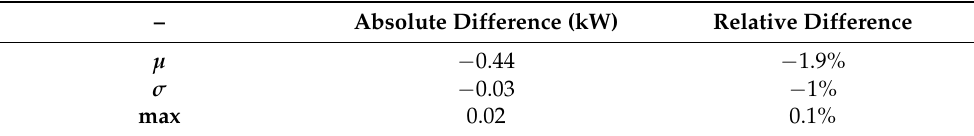
Table 13. Variation of the daily peak of the grid active power demand during May 2020 between Scenario C and Scenario B. µ : average value, σ : standard deviation, max: maximum